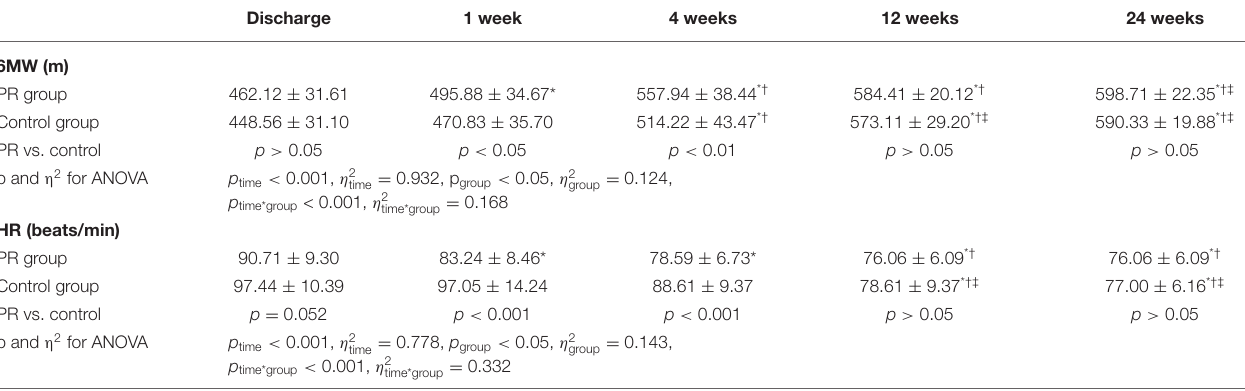
TABLE 4 | Six-min walk distance and heart rate.